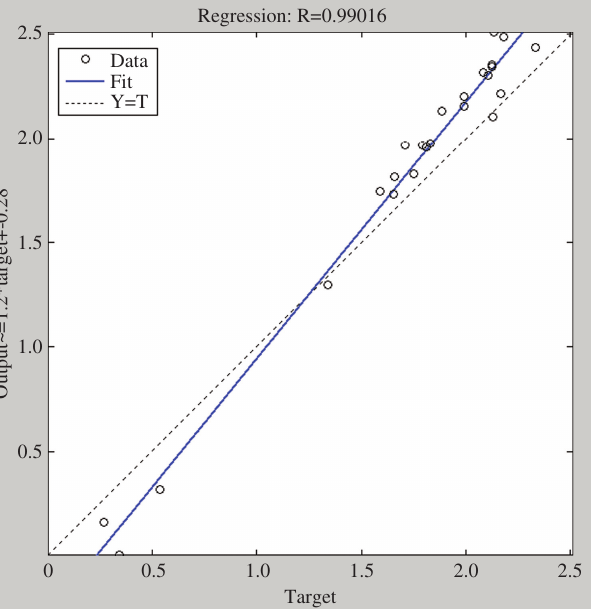
Figure 11. Regression Performance of the WNN.